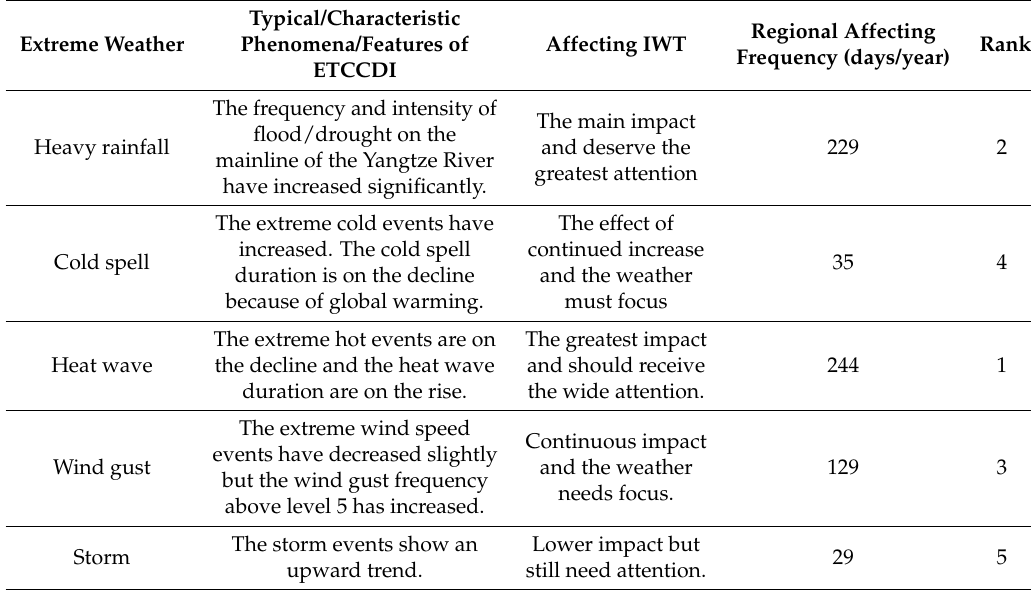
Table 4. Characterizations of extreme weather affecting transportation based on the analysis of ETCCDI on the Yangtze River